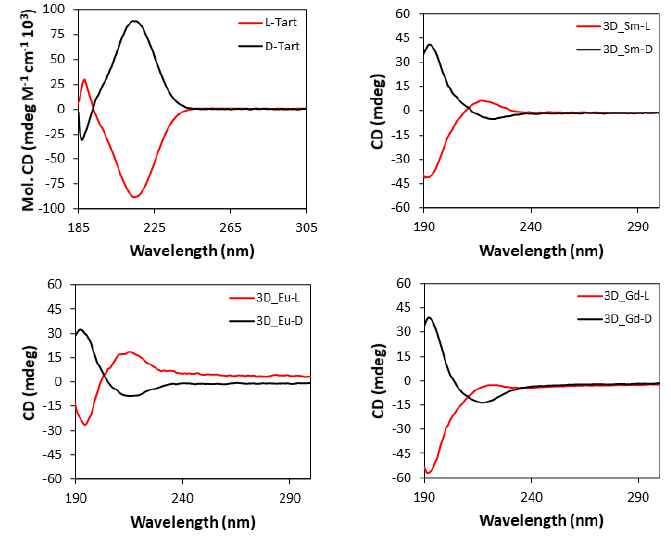
Figure 9. CD spectra of pure L- and D-tartaric acid and 3D_Ln compounds.